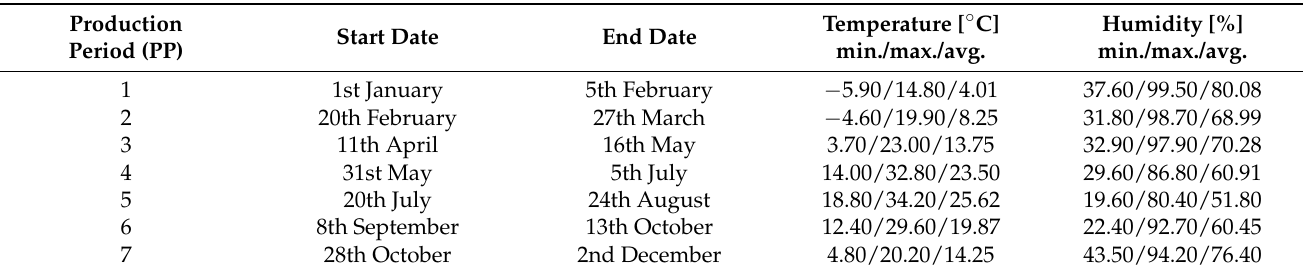
Table 2. Simulated production periods (PPs).